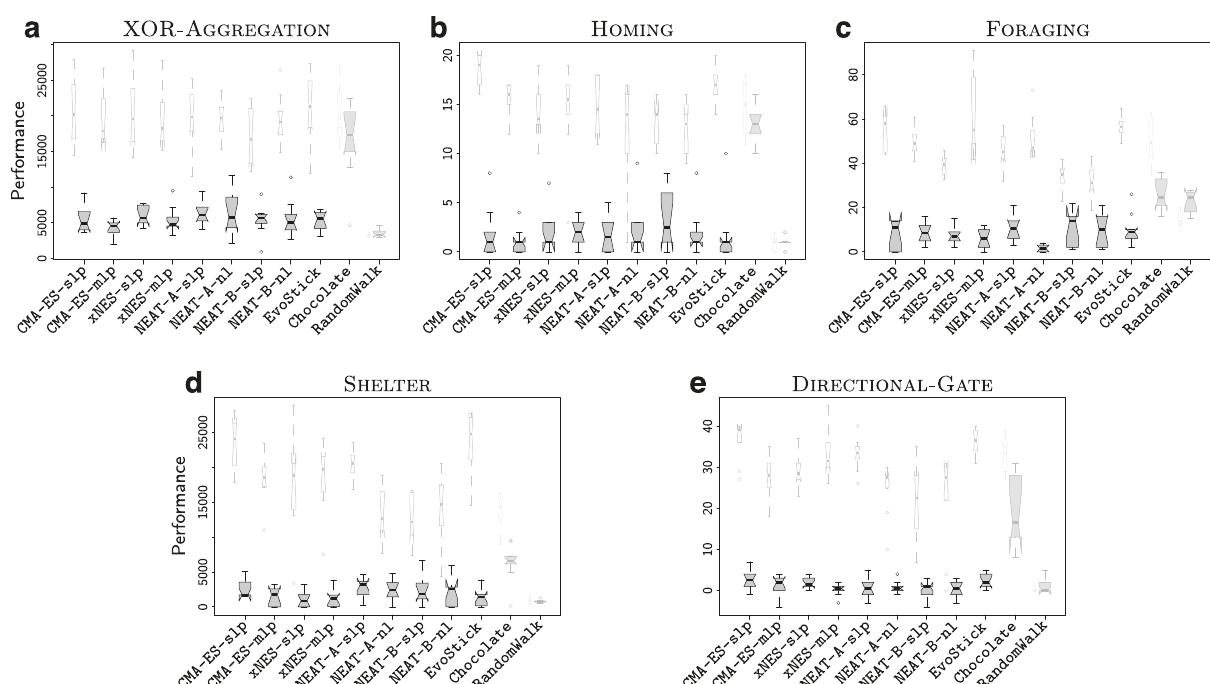
Fig. 4 Results per missions. Performance obtained in simulation (white narrow boxes) and in reality (gray wide boxes) in all fi ve missions: a XOR- AGGREGATION, b HOMING, c FORAGING, d SHELTER, e DIRECTIONAL-GATE. The results are presented using notched box-and-whiskers plots, where the notches represent the 95% con fi dence interval on the median. If notches on different boxes do not overlap, the medians of the corresponding methods differ signi fi cantly, with a con fi dence of at least 95%. Graphical conventions adopted in box-and-whisker plots are described in “ Methods ” under the heading Statistics. The performance of Chocolate and RandomWalk is grayed out so as to focus the attention of the reader to the neuro-evolutionary methods under analysis. The videos of all robot experiments are available as Supplementary Movie 1 –